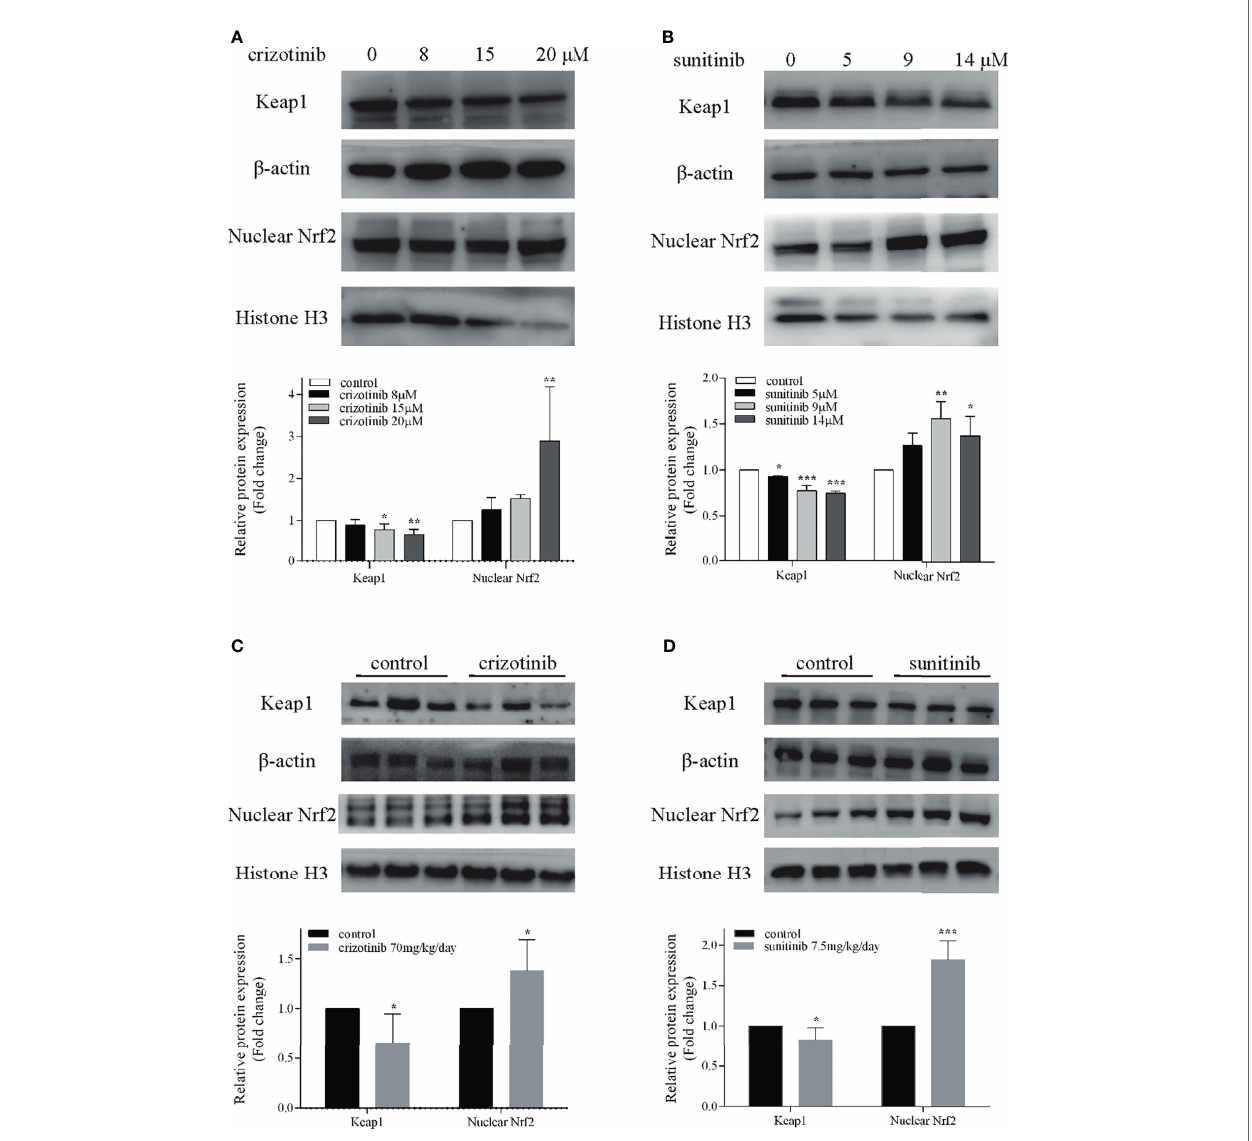
FIGURE 7 | Involvement of the Nrf2 pathway in crizotinib- or sunitinib-mediated hepatotoxicity in vitro and in vivo . (A, B) The protein expression of Keap1 and nuclear Nrf2 in HepG2 cells (n = 3). (C, D) The hepatic Keap1 and nuclear Nrf2 protein levels in mice treated with crizotinib or sunitinib alone (n = 6). b -actin: loading control of total protein; Histone H3: nuclear loading control. *P < 0.05, **P < 0.01 or ***P < 0.001 (the crizotinib or sunitinib alone vs. control). Keap1, Kelch-like ECH- associated protein-1; Nrf2, Nuclear factor erythroid-2 related factor